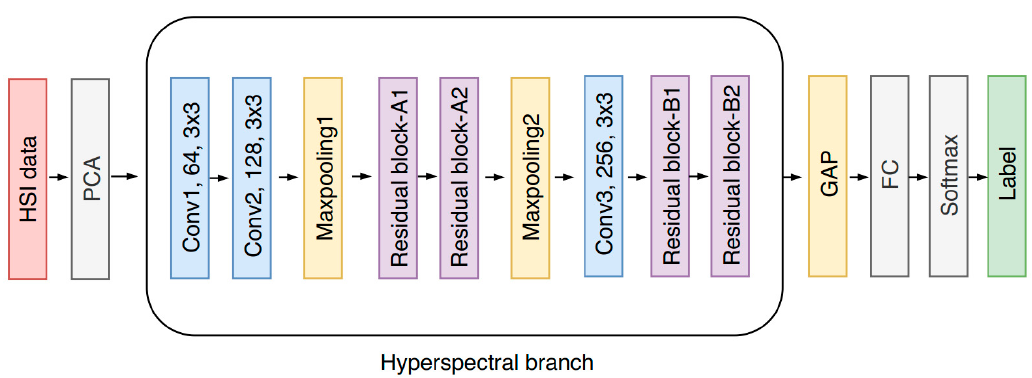
Table 2. Configuration of the proposed HSI branch . Figure 3. Architecture of the proposed hyperspectral imagery (HSI) branch.